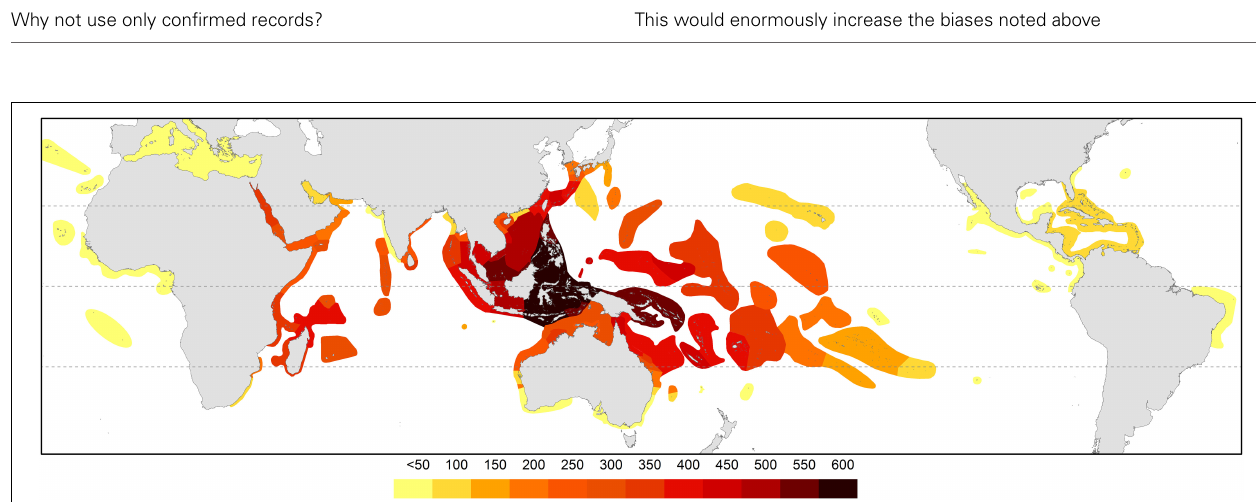
Figure 15, showing geographic ranges and Figure 16, showing numbers of confirmed and strongly predicted Indo-Pacific species richness, were both generated by Excel directly from the Coral Geographic database. Figure 17, centroid positions (meaning the center of grav- ity of each ecoregion polygon) were calculated (in two dimen- sions, longitude and latitude) by averaging the coordinates of all of vertices along the perimeter of each polygon. Centroid calculations were performed in ArcMap 10.2.1 (ESRI,